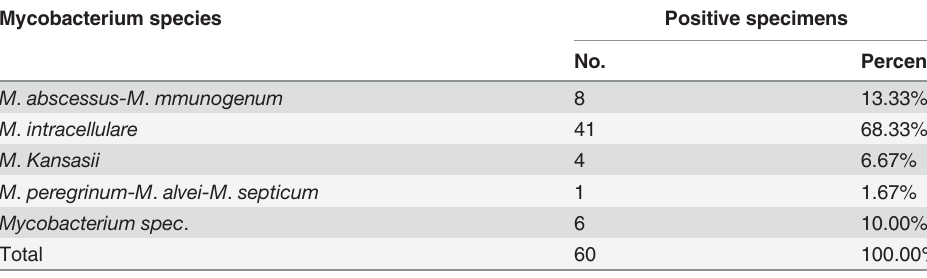
Mycobacterium spec